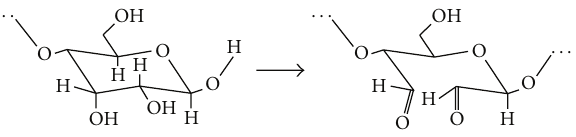
Figure 4: Formation of dialdehyde starch.